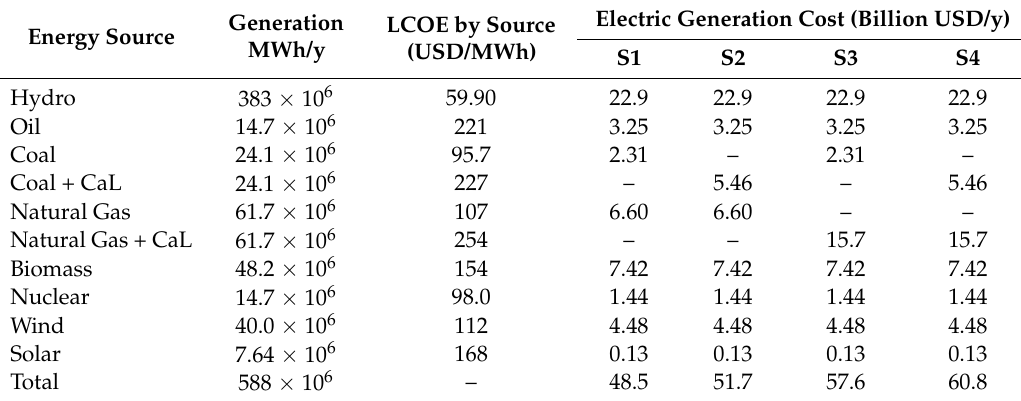
Table 8. Electricity generation and economic performance by source and scenario.